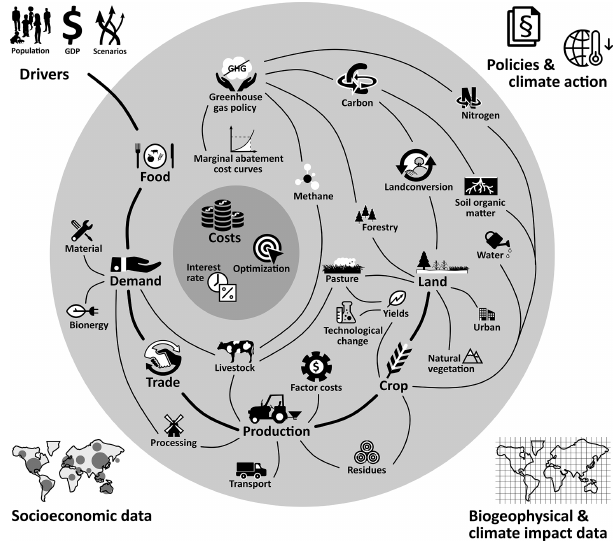
Figure 1. MAgPIE 4 framework with simplified modular structure and module interactions. See the model documentation (Dietrich et al., 2018d) for a more detailed presentation of module interac- tions and their